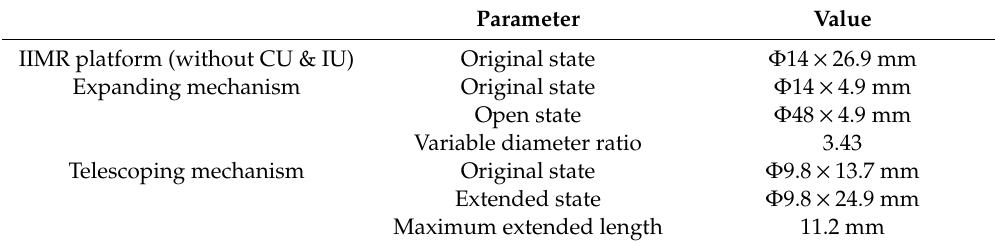
Figure 2. The structure of the novel inchworm-like intestinal micro-robot system. Table 1. The size parameters of the IIMR platform.